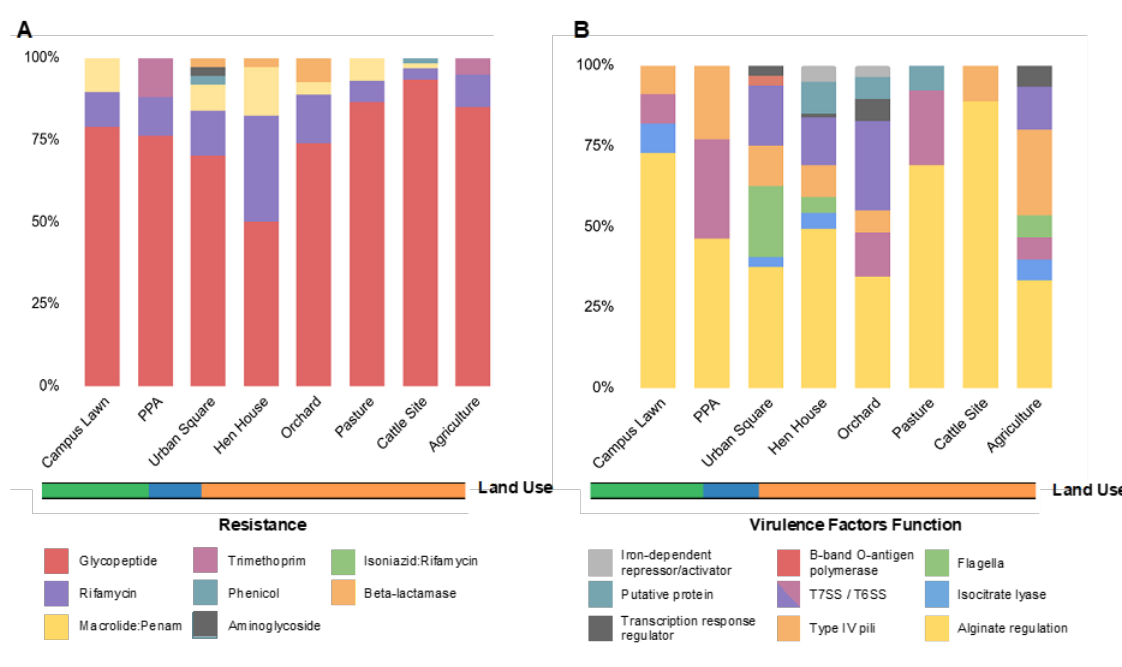
Figure 2. Relative abundances of ARGs and VFs per soil metagenome. ( A ) Relative abundances of the identified ARGs per soil metagenome, colored by resistance category, as indicated in the legend. ( B ) Relative abundances of the identified VFs per soil metagenome, colored by function, as indicated in the legend. The ARGs were identified by CARD and VFs by VFDB, and the abundances were estimated by dividing the number of distinct resistance genes in the category (i.e., ARG potential resistance or VF function) by the total number of genes for all classes found in that site. Land use is indicated in orange (farming), blue (urban) and green (forest).